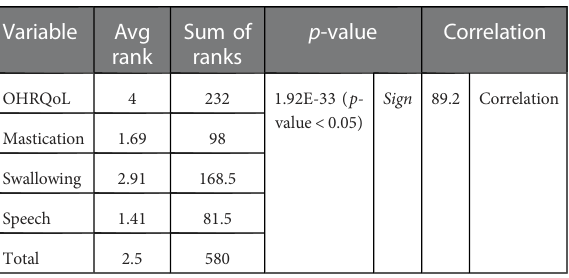
TABLE 6 Relationship between OHRQoL and the three variables of the oral function of the stomatognathic system (chewing, swallowing, and speaking) with the Kendall coef fi cient of concordance.